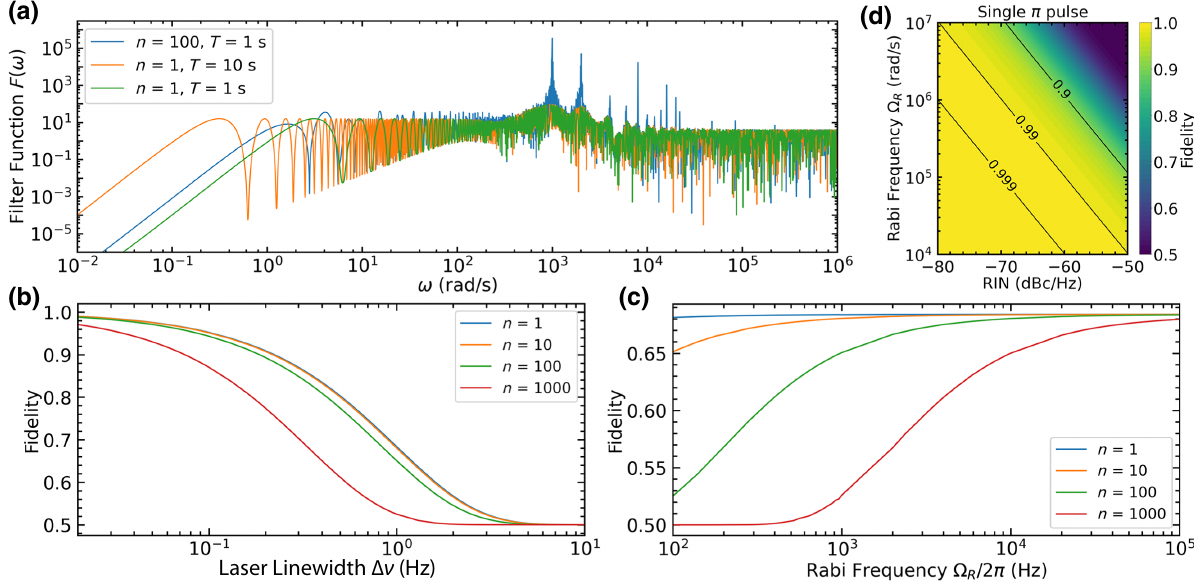
FIG. 2. (a) The filter function calculated for different LMT values [see Fig. 1(a)]. In these calculations, the interferometry time T = 1 s or 10 s, the Rabi frequency (cid:6) R = 10 3 rad/s, and the pulse separation τ = 1 μ s. (b),(c) The fidelity of a LMT sequence (b) as a function of the laser linewidth for a fixed Rabi frequency ( (cid:6) R / 2 π = 10 3 Hz) and (c) as a function of the Rabi frequency at a fixed laser line width ( (cid:4)ν = 1 Hz). In both cases, τ = 1 μ s and T = 1 s. (d) The fidelity of a single π pulse as a function of the RIN level and the Rabi